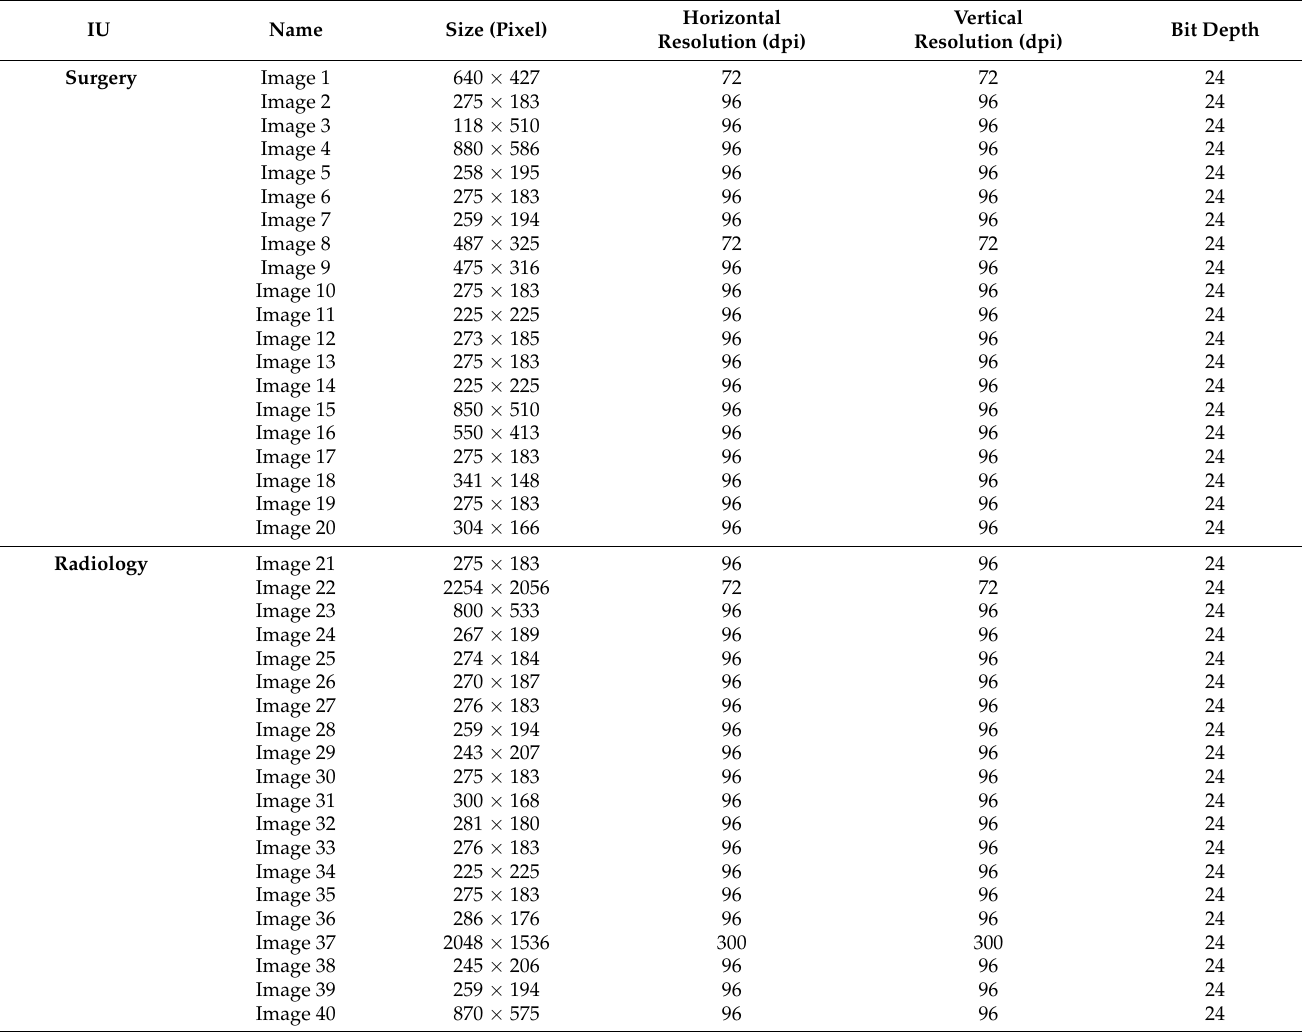
Table A5. Dataset employed to test the three general models and to train and test the two versions of the model described in Section